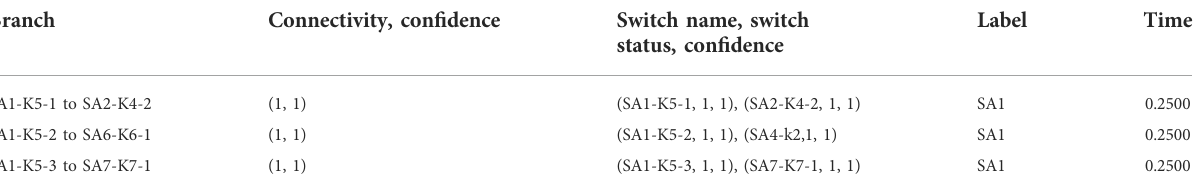
TABLE 5 Preliminary judgement of SA1 in Round 1.